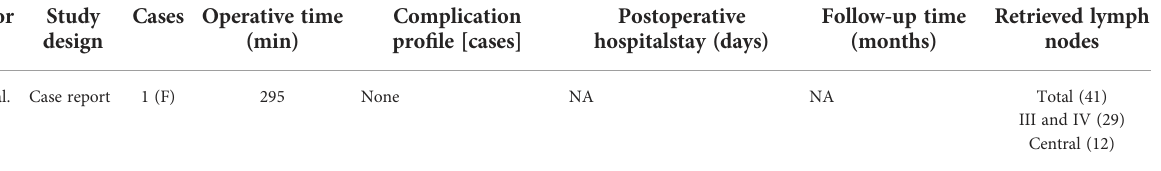
TABLE 5 Summary of studies of robotic transoral